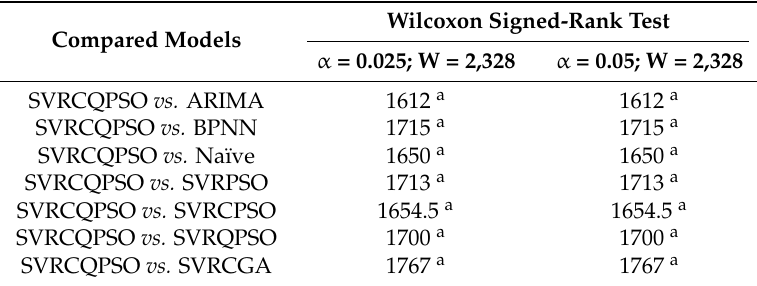
Table 7. Wilcoxon signed-rank test (example